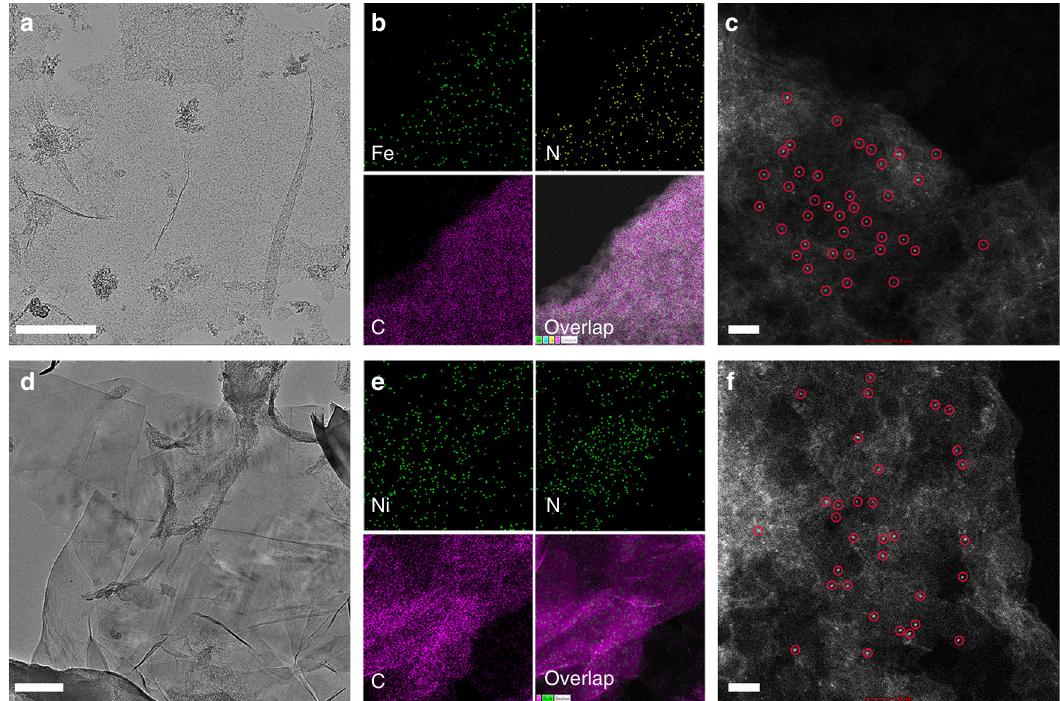
Fig. 3 Microstructure and morphology characterizations of Fe-ISA/CNS and Ni-ISA/CNS. a – d Typical TEM images. Scale bar, 500 and 200 nm. b – e Corresponding EDX elemental mapping. c – f Aberration-corrected HAADF-STEM images. Scale bar, 2